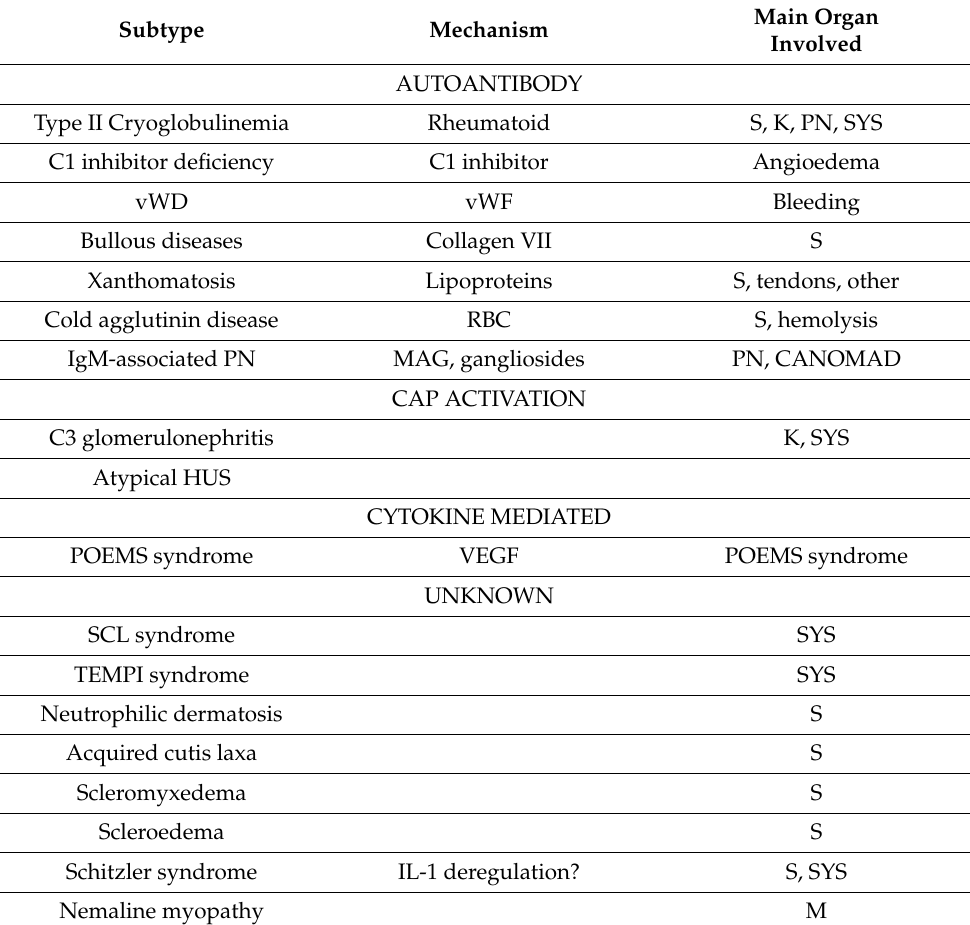
Table 8. Pathophysiological classification of MGCS.